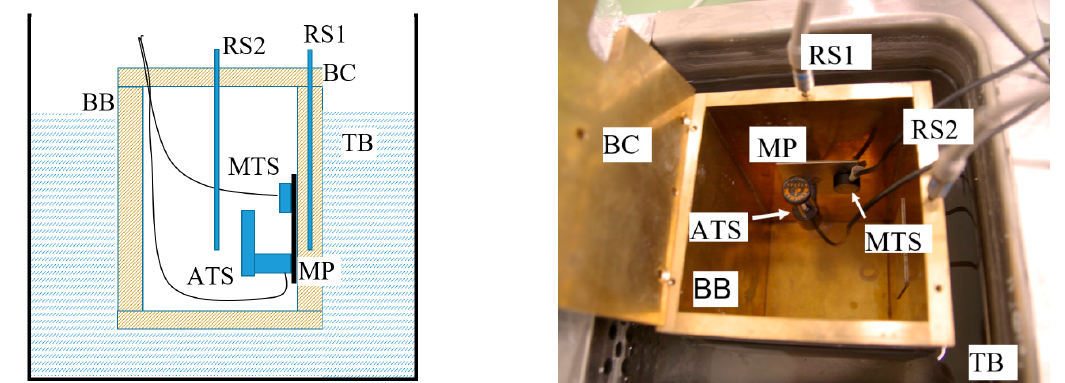
Figure 8. Schematic and realization of a calibration set-up for temperature sensors. TB: thermostatic bath; BB: brass box; BC: brass cover; MP: metal plate; RS1,2: reference Pt100-sensors 1; MTS: material temperature sensor; ATS: air temperature sensor.